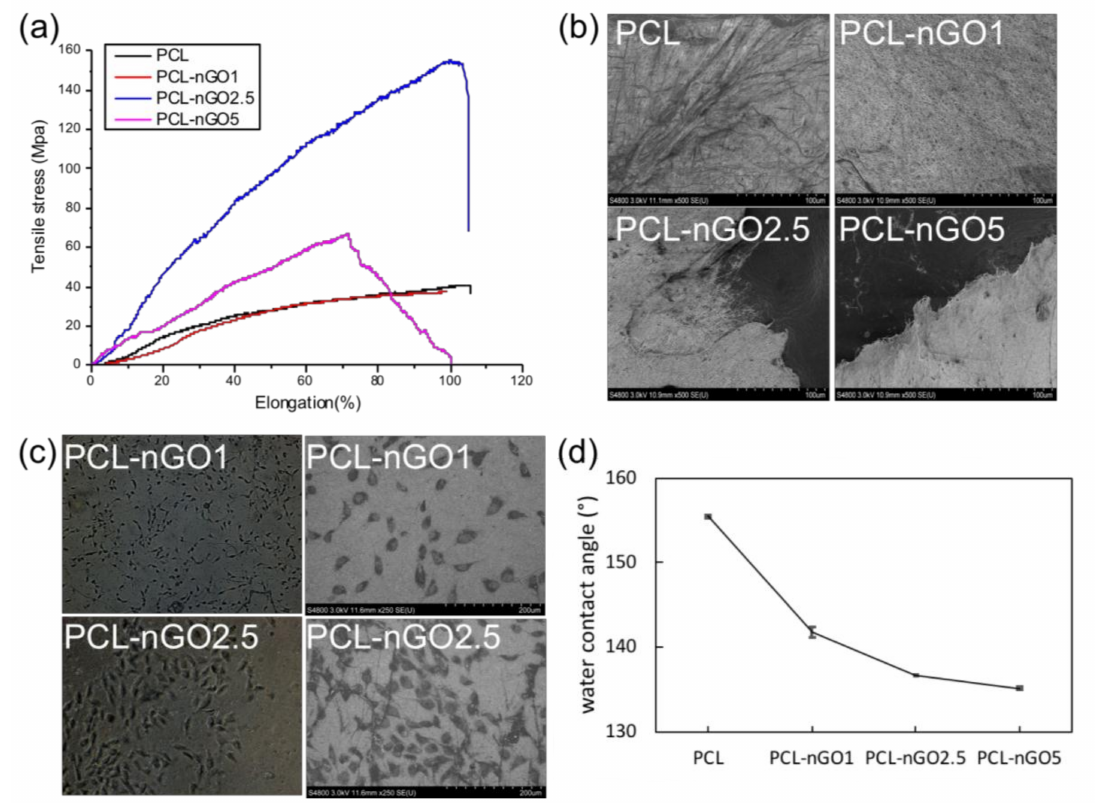
Figure 9. ( a ) Stress–strain curves of PCL, PCL-nGO1, PCL-nGO2.5, and PCL-nGO5 fibers; ( b ) SEM images of PCL, PCL-nGO1, PCL-nGO2.5, and PCL-nGO5 fibers after tensile break; ( c ) Optical microscopy images and SEM images of PCL-nGO1 and PCL-nGO2.5 after 4 days of cell culture; ( d ) Water contact angle measurements on PCL, PCL-nGO1, PCL-nGO2.5, and PCL-nGO5